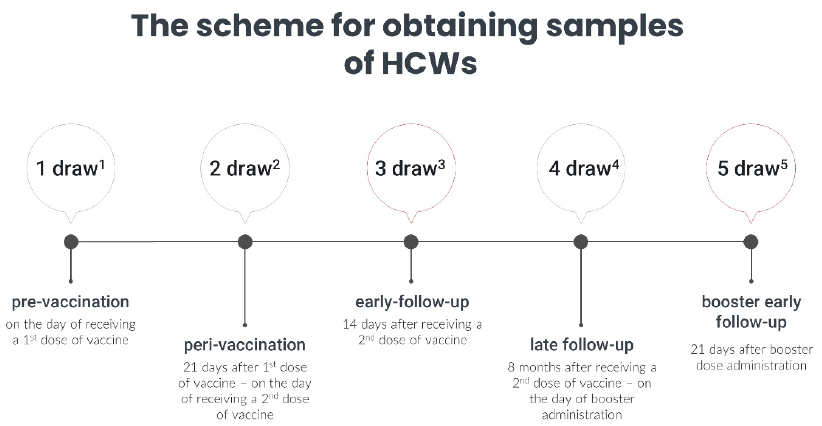
Figure 1. Schematic timetable of blood collections in the group of HCWs. 1 first draw before starting the vaccination; 2 second draw on the day of receiving the second dose of the BNT162b2 vaccine; 3 third draw 14 days after receiving the second dose of the BNT162b2 vaccine; 4 fourth draw 8 months after receiving the second dose of the BNT162b2 vaccine; 5 fifth draw 21 days after receiving the booster dose of the BNT162b2 vaccine.